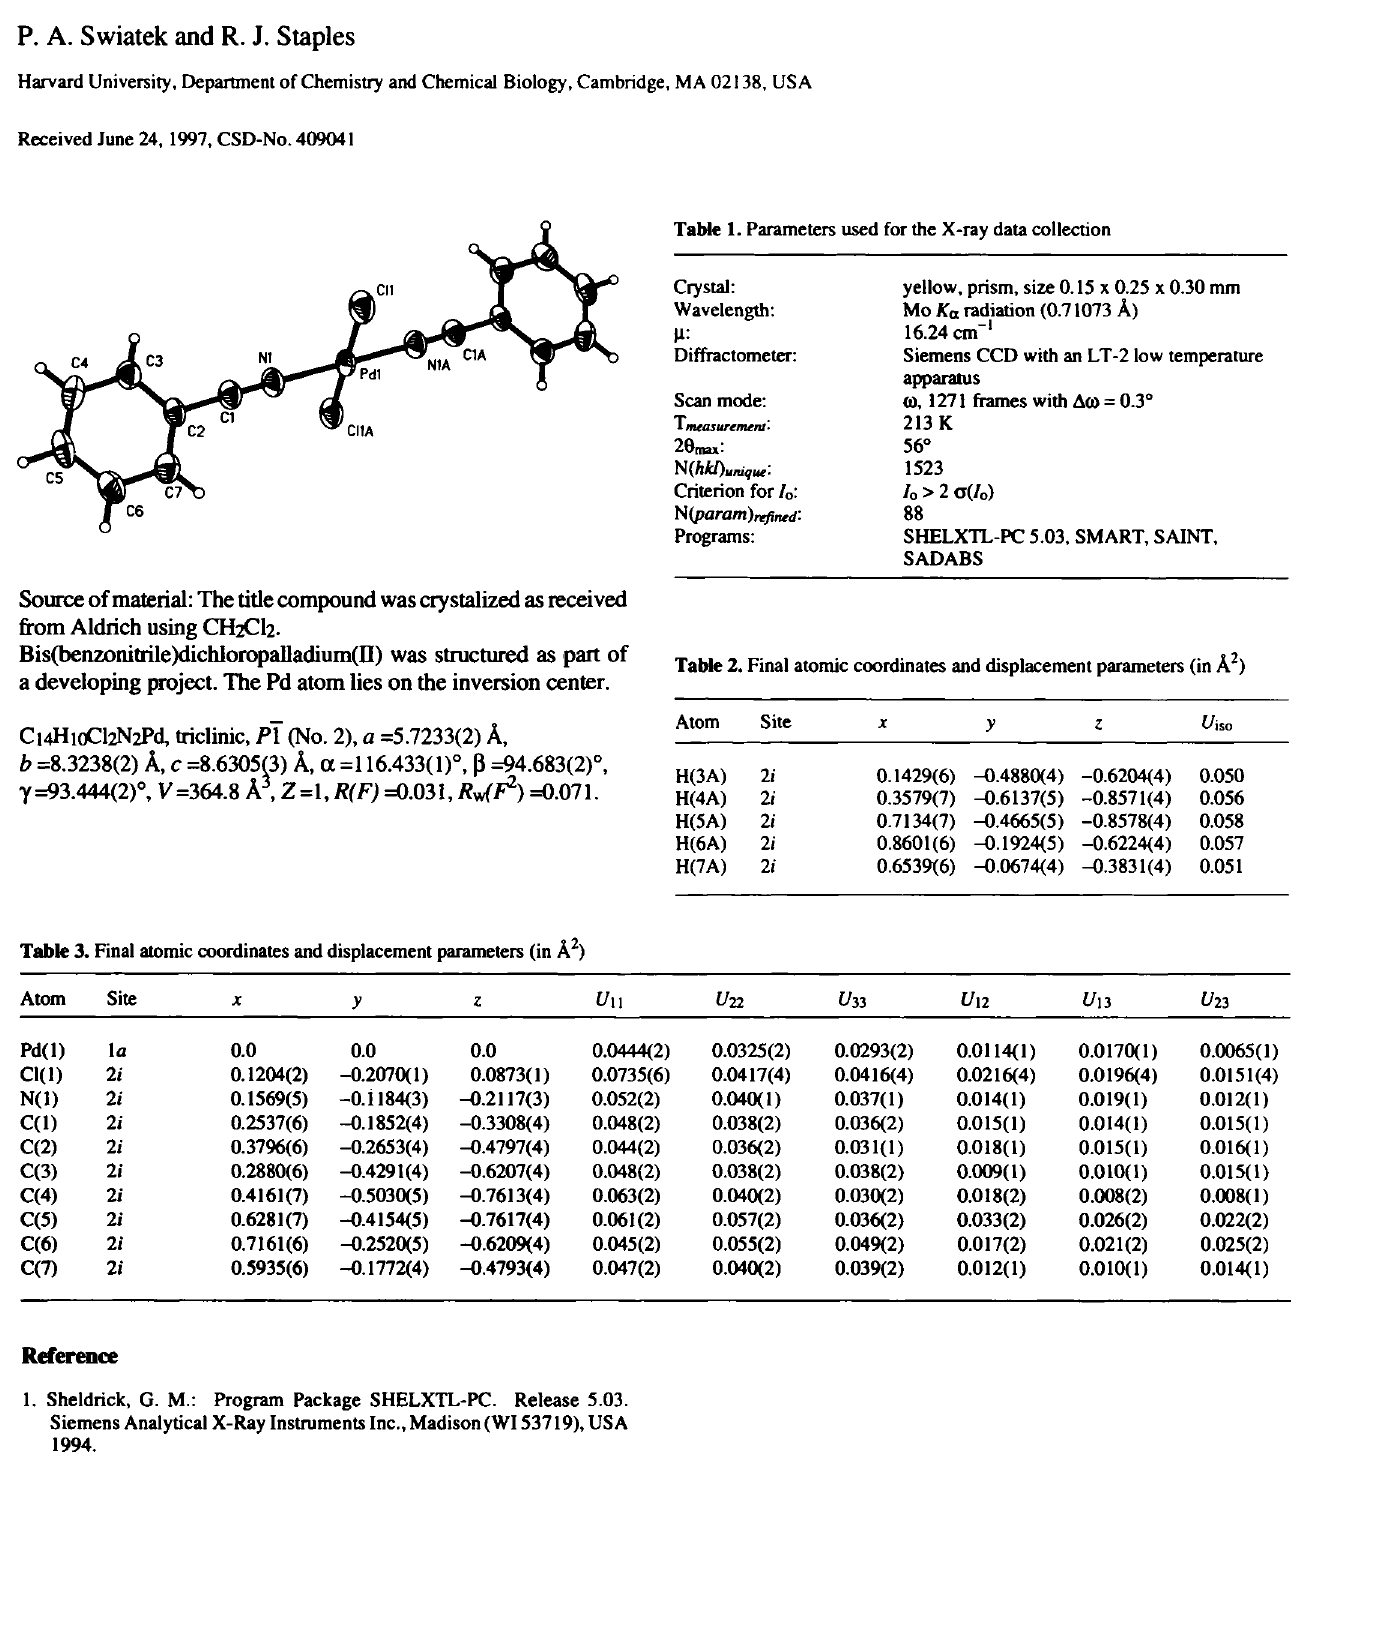
Table 1. Parameters used for the X-ray data collection